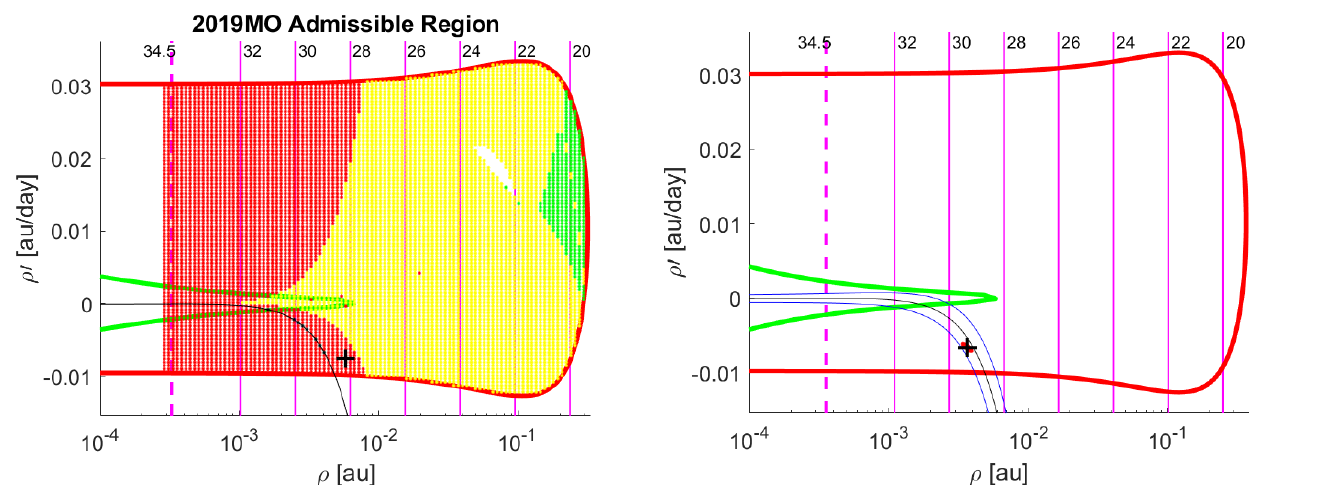
Figure 6. Fit (black curve) and uncertainty (blue curves) of the MOID = 0 line for